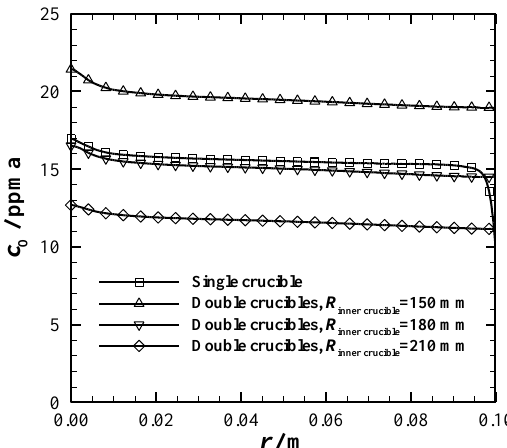
Figure 8. Comparison of O distributions (ppma) at the m-c interface.